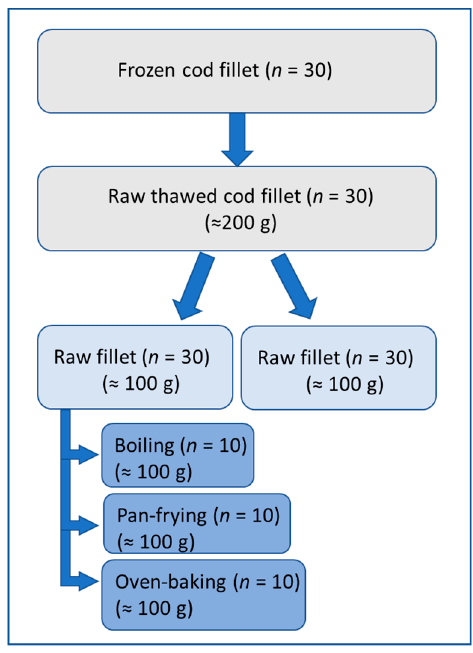
Figure 1. Schematic overview of cod fillet processing.